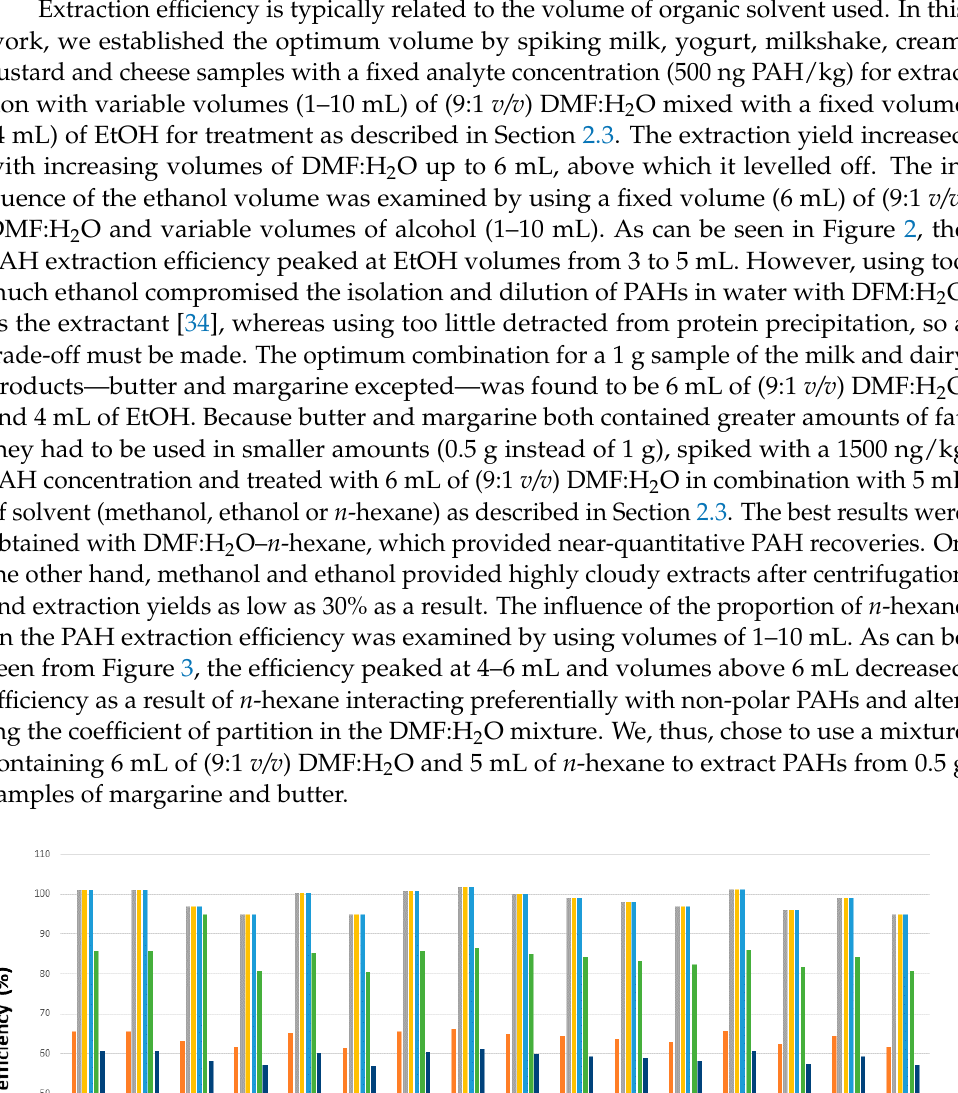
Figure 3. Influence of the volume of n -hexane on the extraction of polycyclic aromatic hydrocarbons from butter and margarine. The influence of centrifugation-related variables (time, temperature and speed) was examined using 1 g amounts for all milk and dairy products except butter and margarine (0.5 g) and following the PAH extraction procedure described in the previous paragraph. The temperature, centrifugation speed and time ranges studied were 0–10 °C, 430–2150 g and 1–30 min, and the optimum obtained values were 4 °C, 2150× g (5000 rpm) and 15 min, respectively.